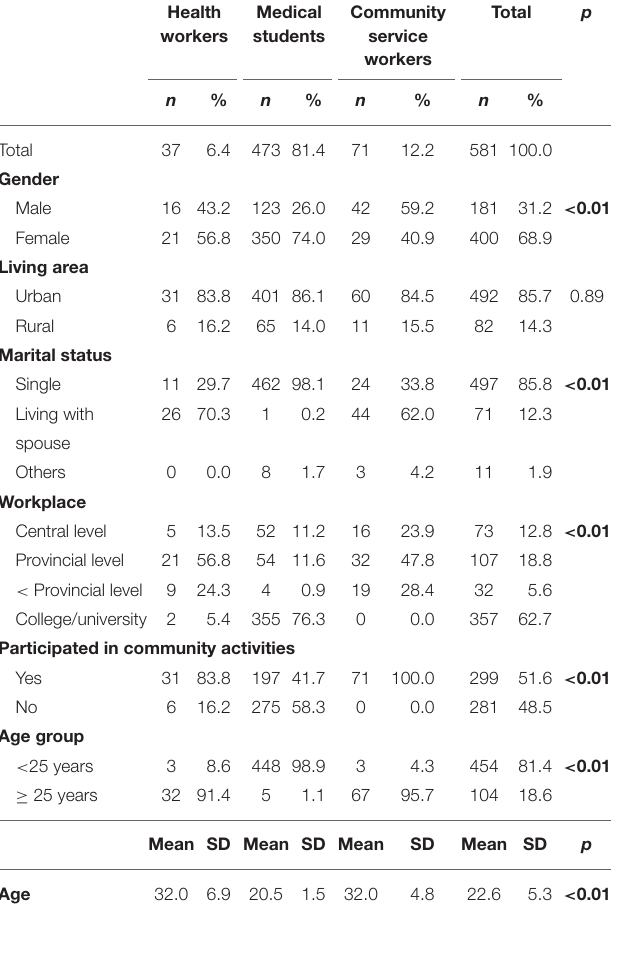
TABLE 2 | The perceived importance of organizations in health care, epidemic preparedness, and response at grassroots levels (10-point